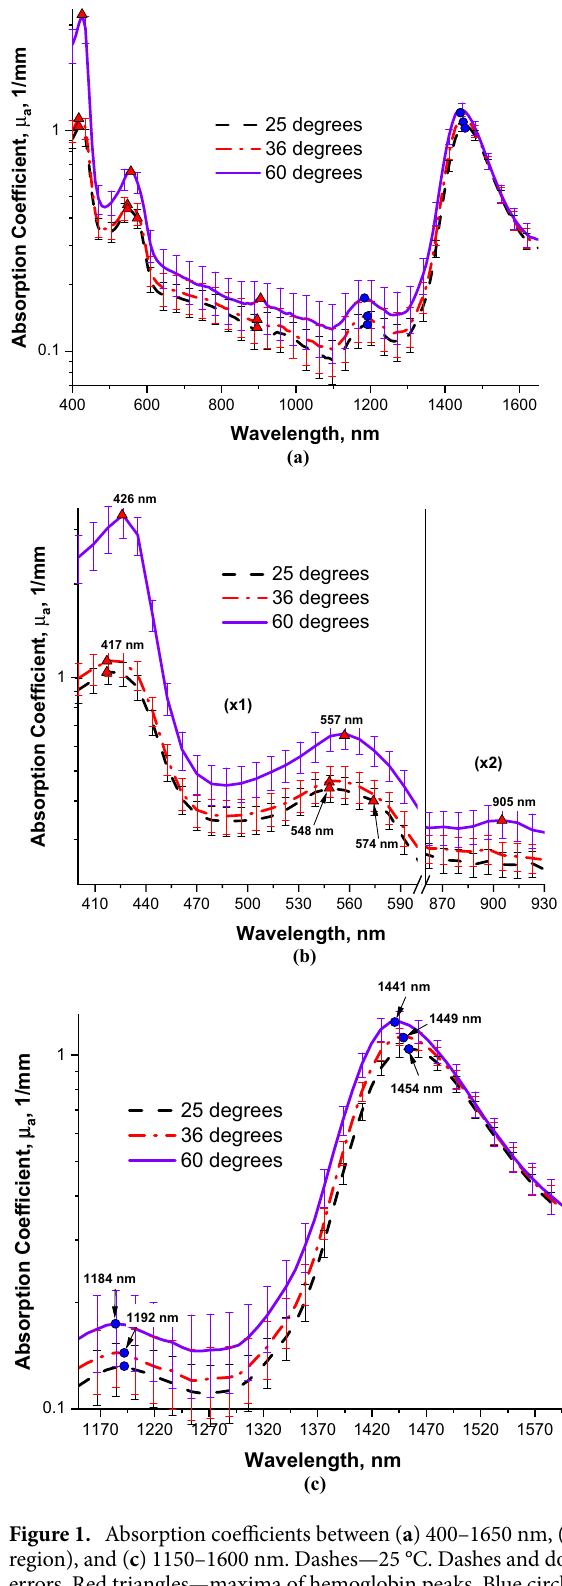
Figure 1. Absorption coefficients between ( a ) 400–1650 nm, ( b ) 400–930 nm (note the scale change in the NIR region), and ( c ) 1150–1600 nm. Dashes—25 °C. Dashes and dots—36 °C. Solid line—60 °C. Bars—standard errors. Red triangles—maxima of hemoglobin peaks. Blue circles—maxima of water